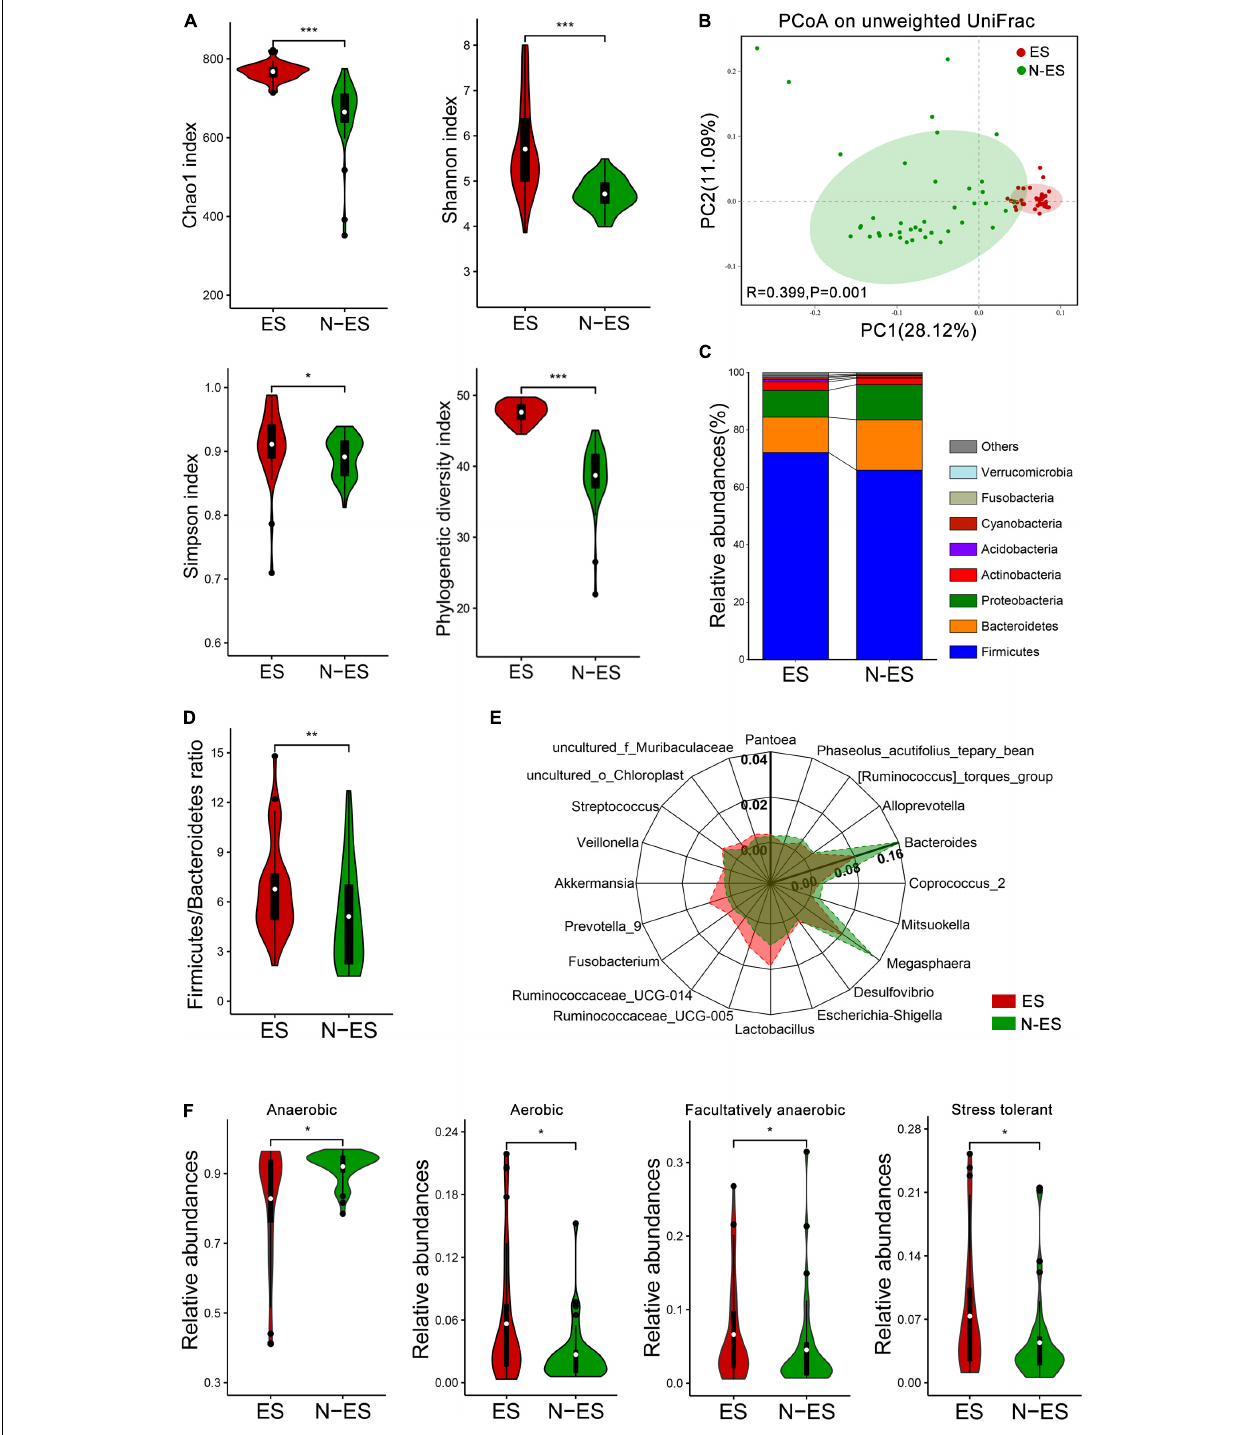
FIGURE 1 | Characteristics of the gut microbiota in elite soldiers (ES) and non-elite soldiers (N-ES). (A) Comparison of Chao1, Shannon, Simpson, and phylogenetic diversity indices of microbial communities between the two groups. (B) Principal coordinates analysis (PCoA) of the gut microbiota based on unweighted UniFrac distance metrics for ES and N-ES. ANOSIM, R = 0.399, P = 0.001. (C) Bacterial proportions at the phylum level. (D) The values of Firmicutes / Bacteroidetes of ES showing significantly higher than that of the N-ES cohort. (E) Radar charts depict information on the discriminative microbiota between ES and N-ES cohorts at the genus level. The differential genera with mean relative abundances more than 0.2% of the total abundance are presented for clarity. Except for Bacteroides with the unique axis scale, the remaining genera have been presented using the same options for axes. (F) The estimate of phenotypic compositions in ES versus N-ES. * P < 0.05, ** P < 0.01, *** P < 0.001, Mann–Whitney U -test with false discovery rate correction.